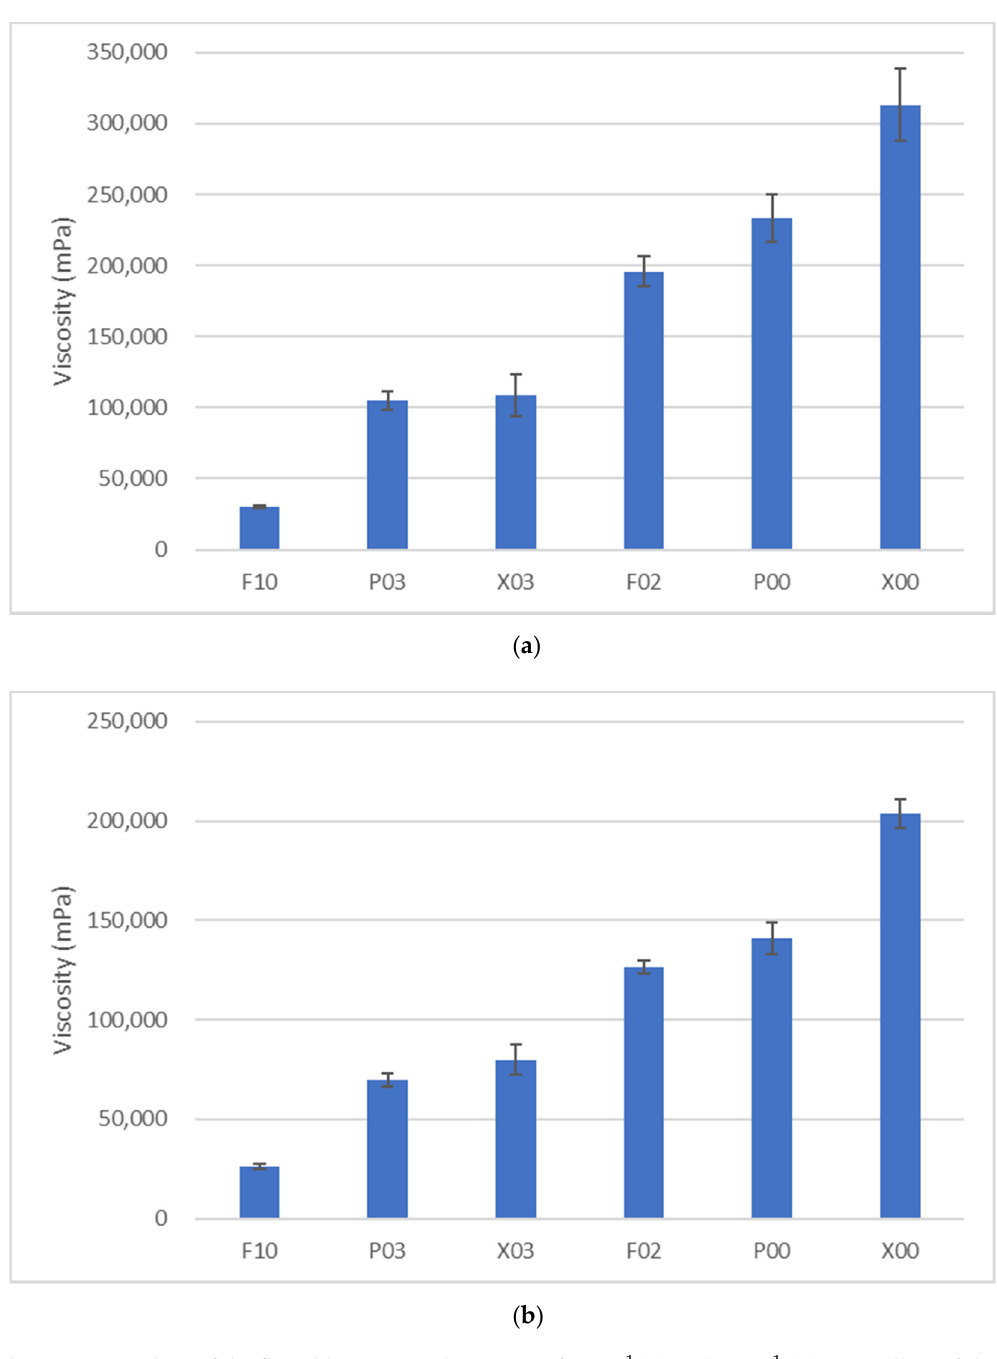
Figure 5. The viscosity values of the flowable resins at shear rates of 1.0 s − 1 ( a ) and 2.0 s − 1 ( b ). Regardless of shear rate, the viscosity value of the flowable resins was highest for X00, followed by P00, F02, X03, P03, and F10, in that order.